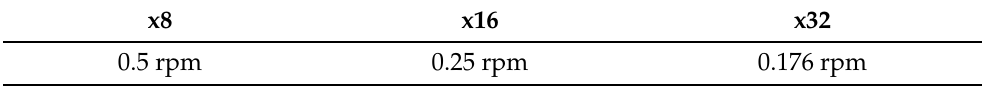
Table 4. Shaft rotational speed set in experiments as a function of microstepping resolution.